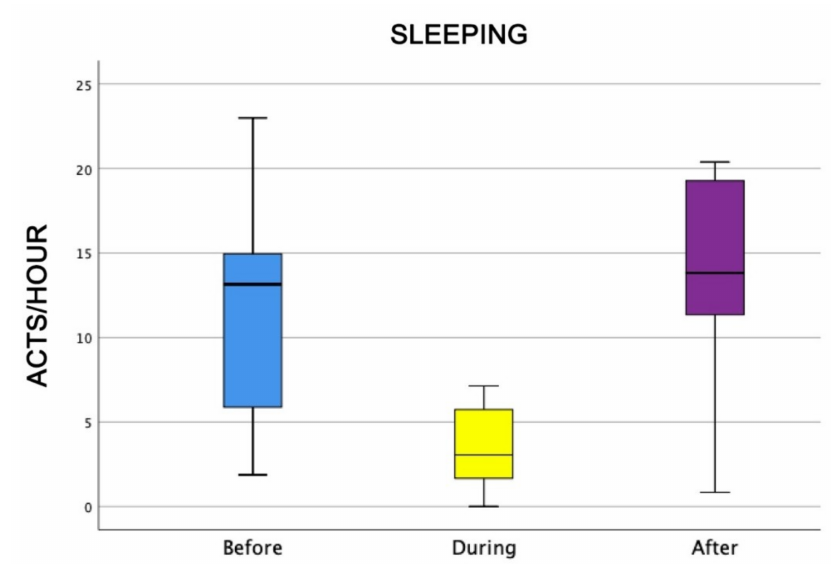
Figure 9. Number of times dogs had been sleeping before, during, and after AAI sessions. Non-parametric data are represented as medians (horizontal bar in the box) and the box indicates the interquartile range of 50% of the data. Whiskers extend to the smallest and largest values and exclude outliers (dot on top).